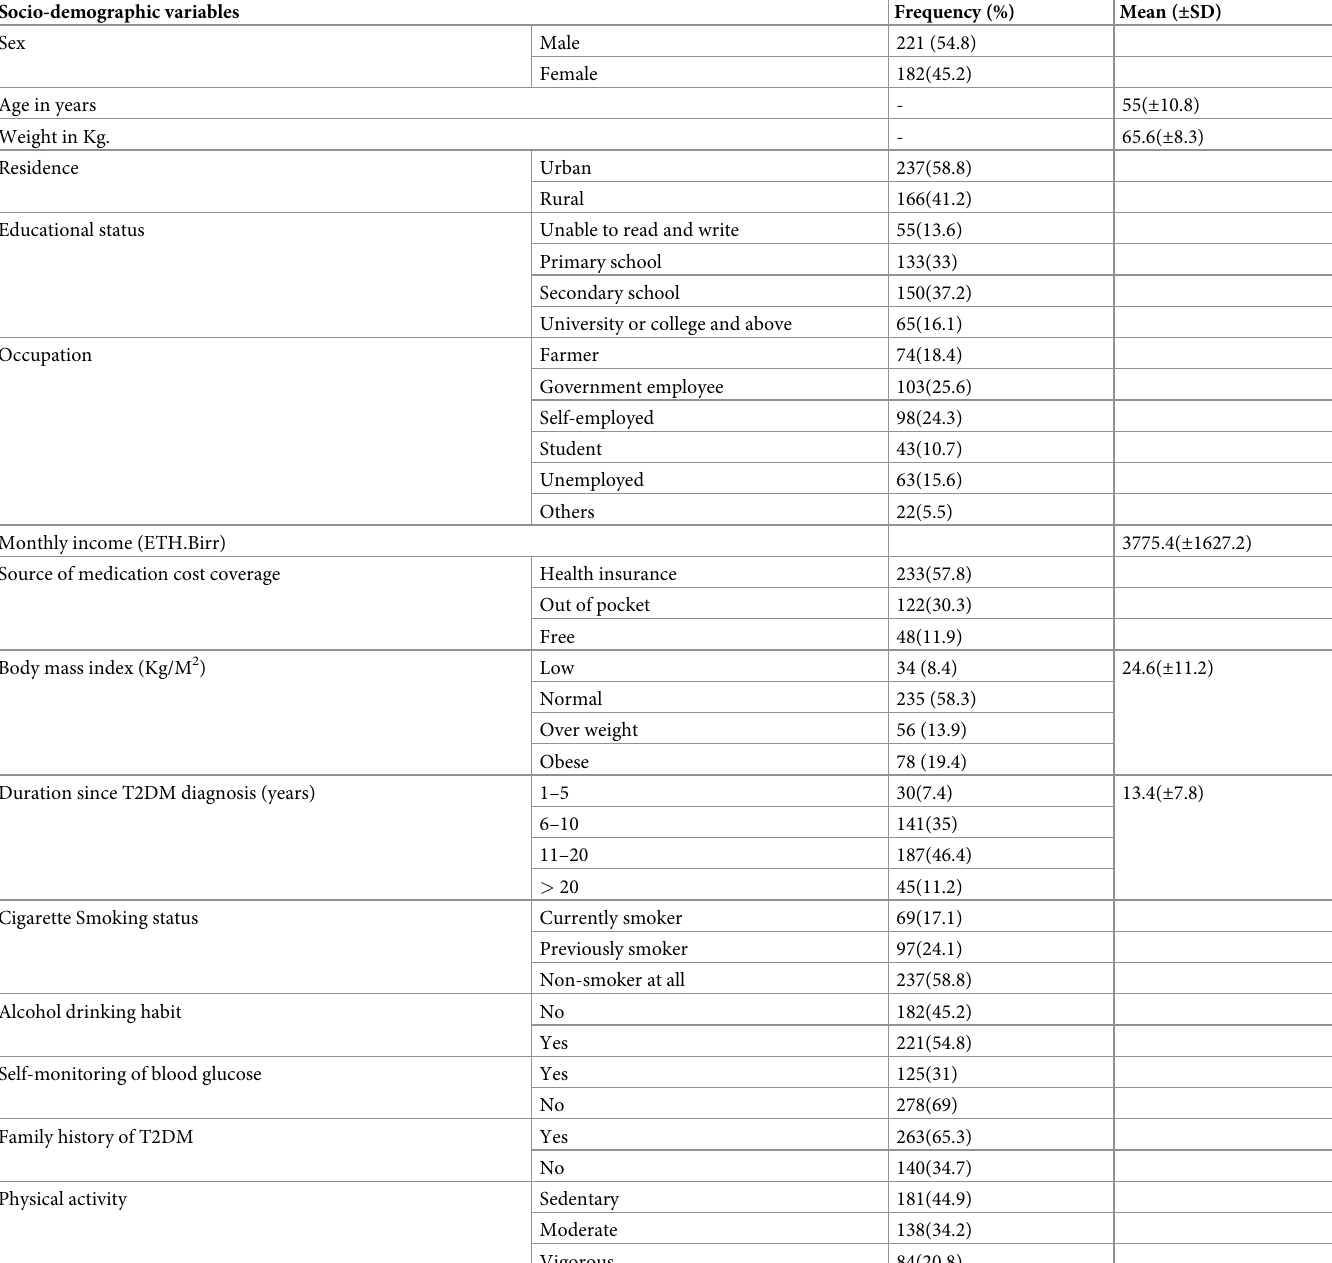
Table 1. Socio-demographic and clinical characteristics of T2DM patients with comorbidity at hospitals in Northwest Ethiopia from January to March, 2022 (N = 403). Socio-demographic